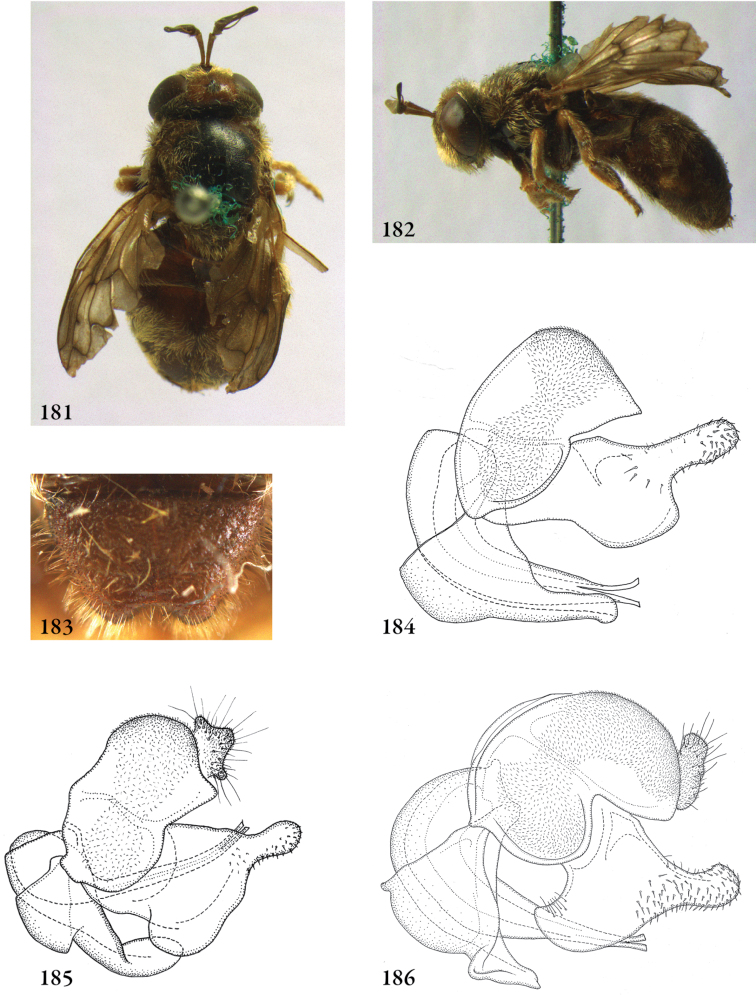
181–182
Microdon (Dimeraspis) marmoratus male (holotype): 181 habitus dorsal 182 habitus lateral 183
Microdon (Dimeraspis) globosus male (USA, Pennsylvania, coll. RMNH), scutellum 184–186
Microdon (Dimeraspis), male genitalia: 184
Microdon globosus (USA, Pennsylvania, coll. RMNH) 185
Microdon abditus (paratype, USA, Queens, coll. RMNH) 186
Microdon fuscipennis (USA, N-Carolina, coll. RMNH).